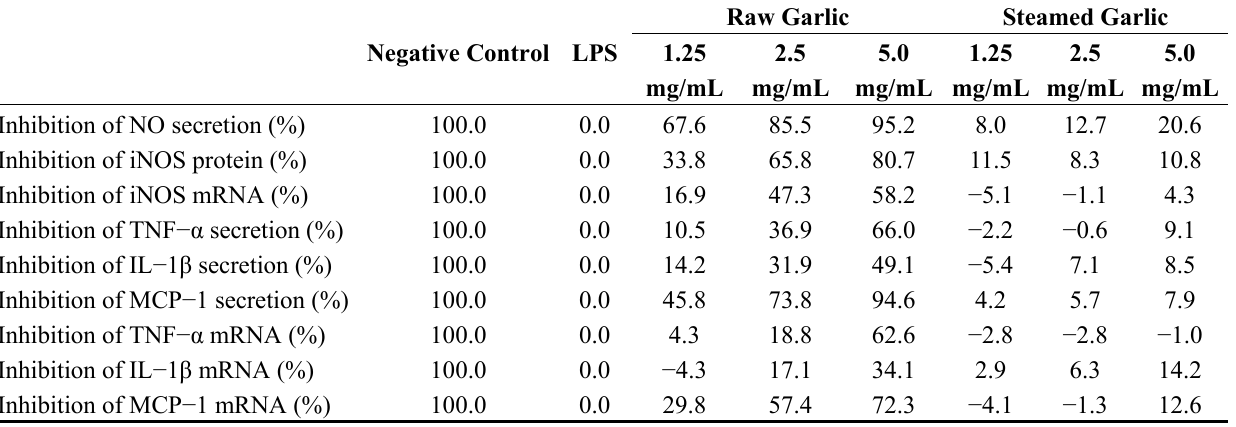
Table 1. Inhibitory rate of raw and steamed garlic extracts on the proinflammatory mediator secretion and mRNA expression in LPS-activated RAW 264.7